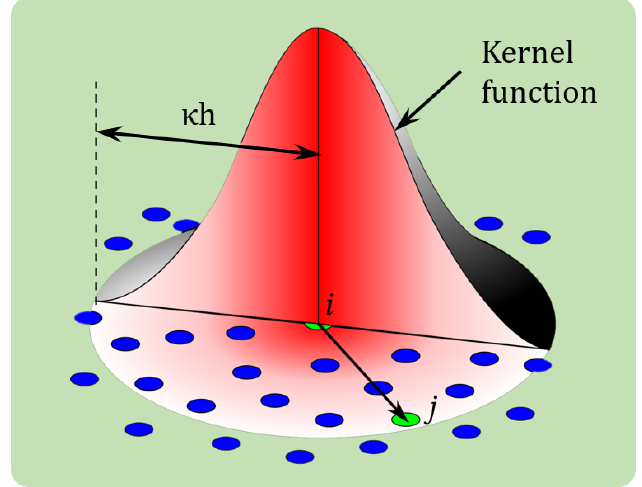
Figure 1. Schematic of the SPH method representing the interaction between particles through the kernel